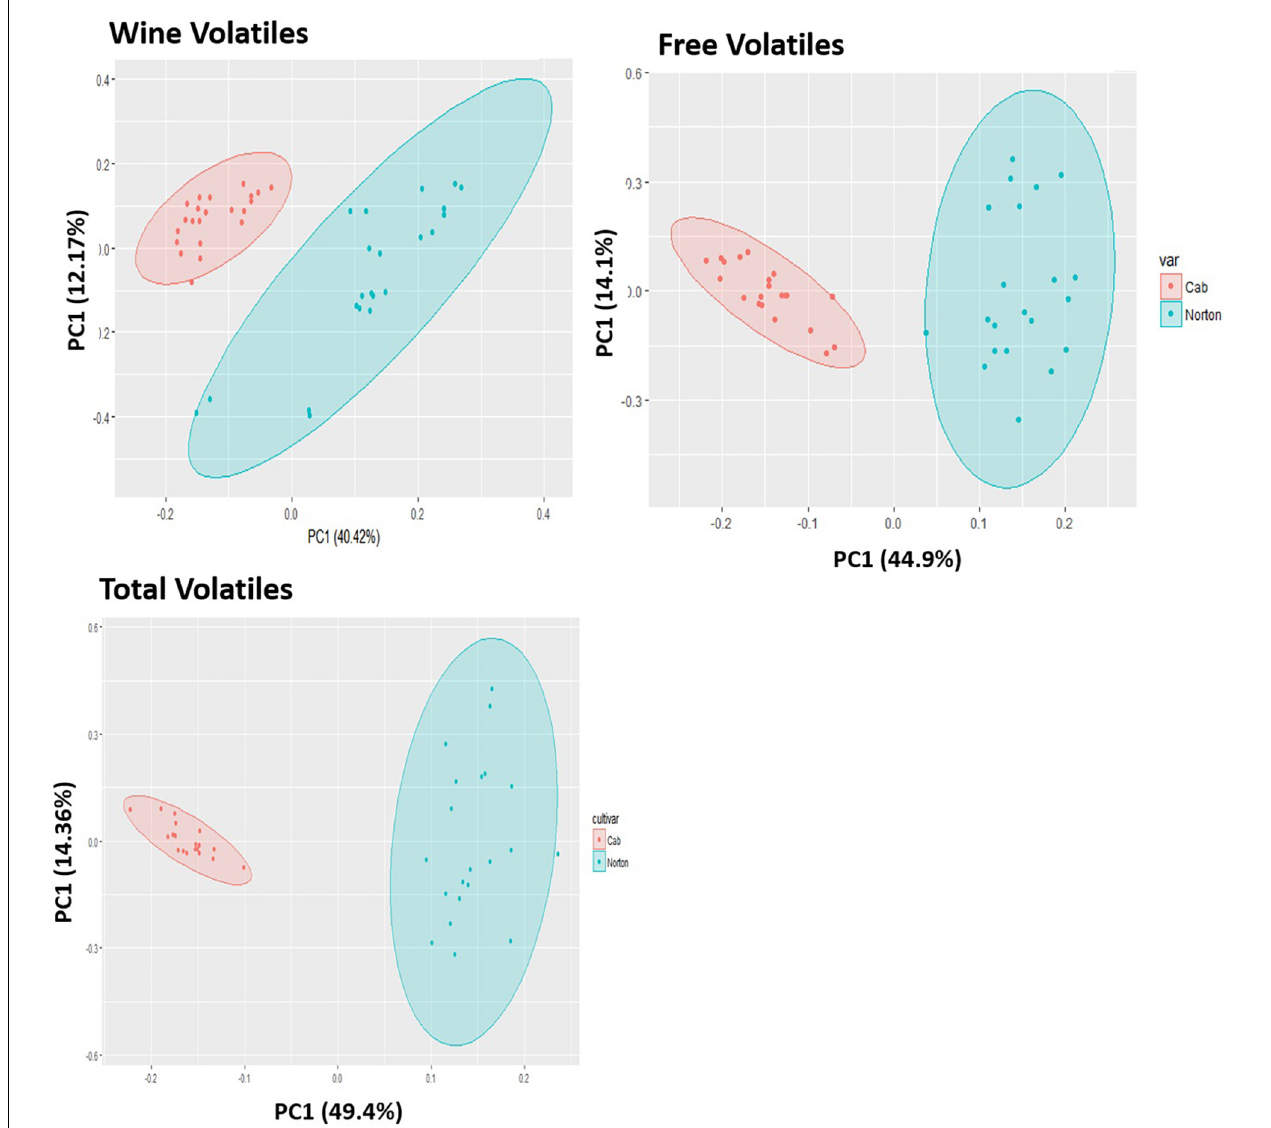
FIGURE 3 | Principal components analysis (PCA) scores plot for the distribution of (A) wine volatiles, (B) free volatiles, (C) total volatiles features in Norton and Cabernet Sauvignon (Cab) grapes and wines. The ellipses show 95% confidence interval. There is a separation based on cultivar for free, total, and wine metabolic